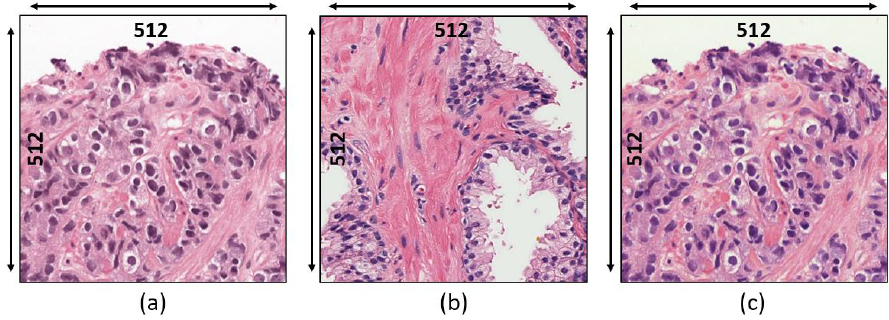
Figure 3. Stain normalization. ( a ) Raw image. ( b ) Reference image. ( c ) Normalized image. On the other hand, stain deconvolution [24] was applied to transform the RGB color image into stain color spaces (i.e., H&E). Examples of separated stain images are shown in Figure 4. All color values on the normalized image I N are converted to their corresponding optical density (OD) values and the computation of OD for each (Red, Green, and Blue) channel can be expressed as follows: